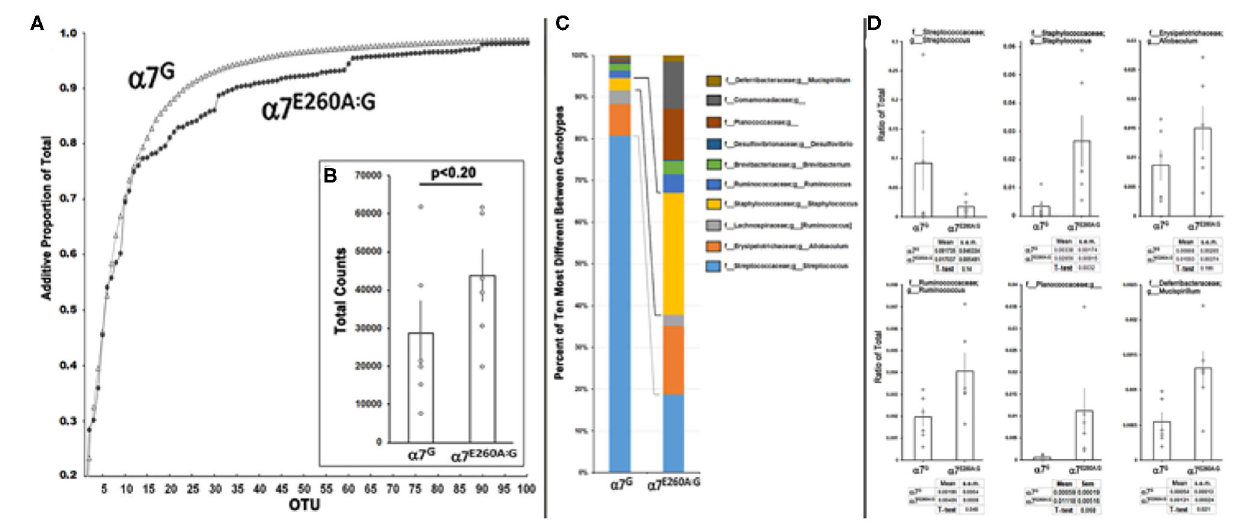
FIGURE 3 | Microbial diversity between α 7 G and α 7 E260A : G mandibular samples. Mandibles of six mice from the indicated α 7 genotypes were prepared, 16S RNA sequencing conducted and the operational taxonomic units (OTU) assigned to the level of genus using the QIIME2 pipeline (Methods). (A) Rarefaction curves show the additive total percentage for the 100 most abundant OTU that were assigned to family or family + genus for α 7 G (open triangles) and the corresponding value in the α 7 E260A : G (filled circles). (B) Total average bacterial counts for each sample. Error bars are the s.e.m.; p is the result of a standard paired t -test. (C) Relative percentage for the top 10 most different OTUs between α 7 genotypes and assigned to a terminal family or genera as labeled. The lines identify notable differences between the relative proportion of Streptococcus sp. (light blue) and Staphylococcus sp. (yellow). (D) Quantitative comparisons for 6 of the most abundant and different OTU between genotypes as a ratio of their abundance in the total MB landscape. The mean and s.e.m. for each sample is listed and the results of a standard t -test that compares the